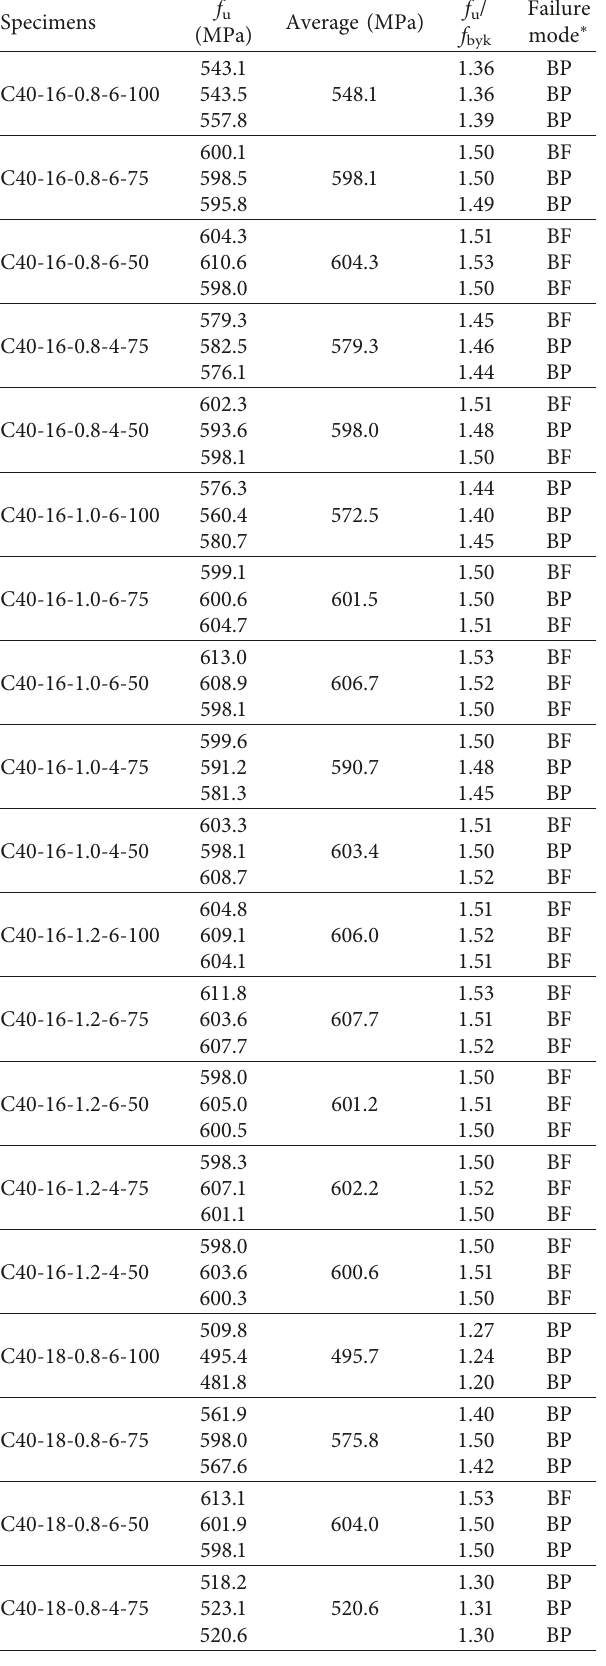
Table 2: Summary of test results. Specimens